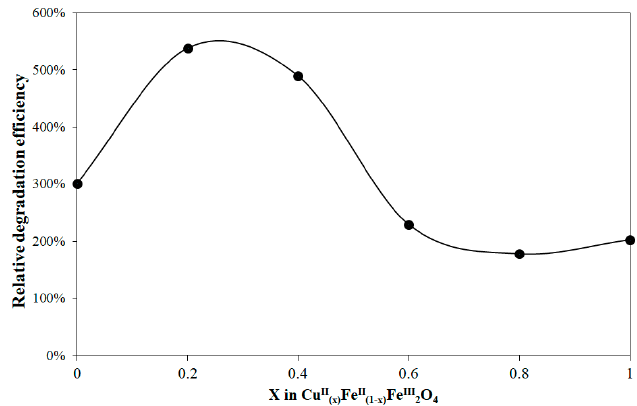
Figure 14. Relative photocatalytic efficiency depending on the ratio Cu 2+ :Fe 2+ in Cu II(x) Fe II(1-x) Fe III2 O 4 at the optimized concentrations: MB = 1.5 × 10 − 5 mol/L, NPs = 400 mg/L, initial pH = 7.5, and H 2 O 2 = 1.76 × 10 − 1 mol/L.